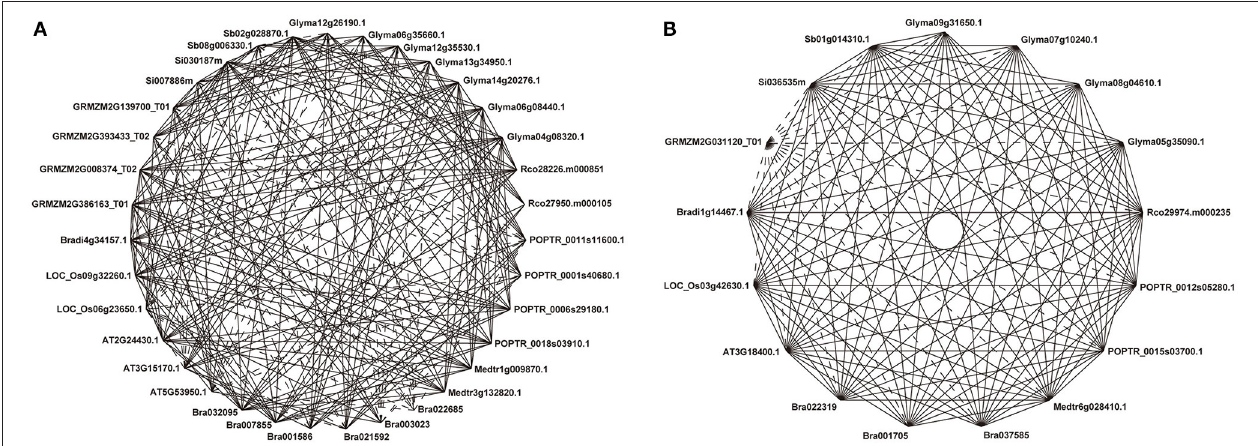
FIGURE 1 | Representative COGs of the Ia subfamily. Ia_1 (A) and Ia_4 (B) . Solid lines show reciprocal BeTs (Best Hits) and broken lines show asymmetrical BeTs. Genes from the same species are adjacent. Each gene ID is indicated, and the prefix “Rco” denotes genes from Ricinus communis .